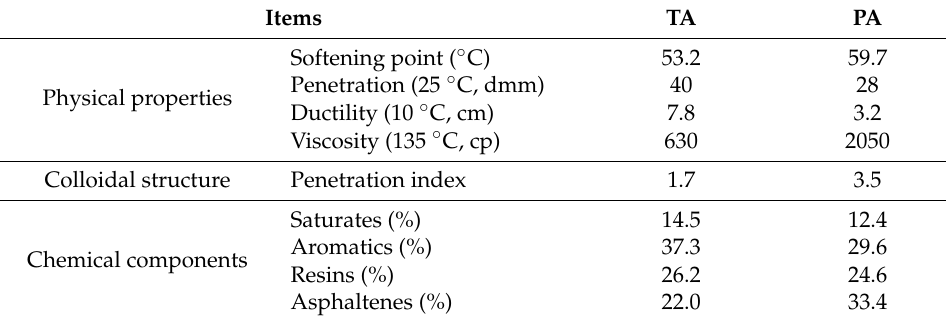
Table 3. Physical properties and chemical components of TA and